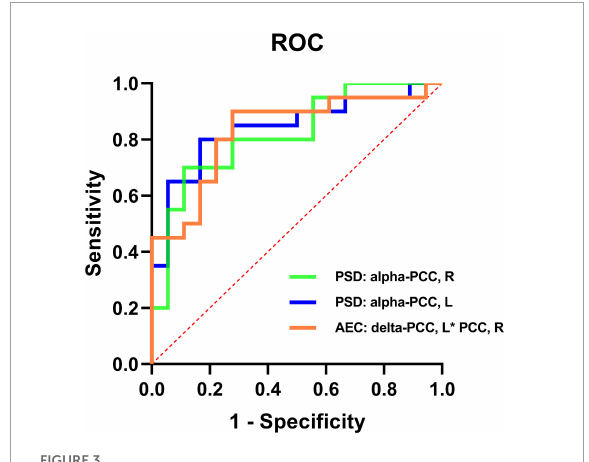
FIGURE3 ROC curves of the spectral power of the bilateral PCCs in the alpha band and the AEC-c value between the bilateral PCCs in the delta band to discriminate mild SWI from typical RE individuals.